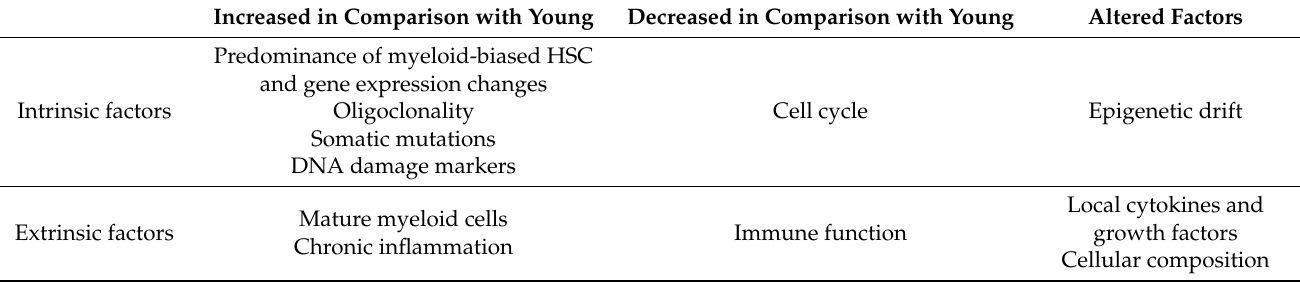
Table 2. Relationship between intrinsic and extrinsic mechanisms associated with aging of hematopoiesis and immune function